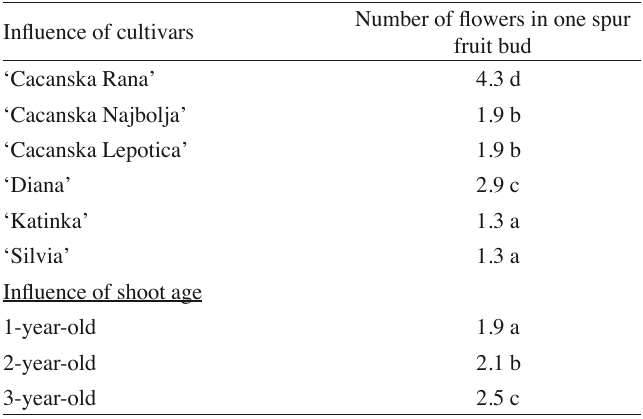
Different letters indicate significant differences separately for cultivars and shoot age at P=0.05.